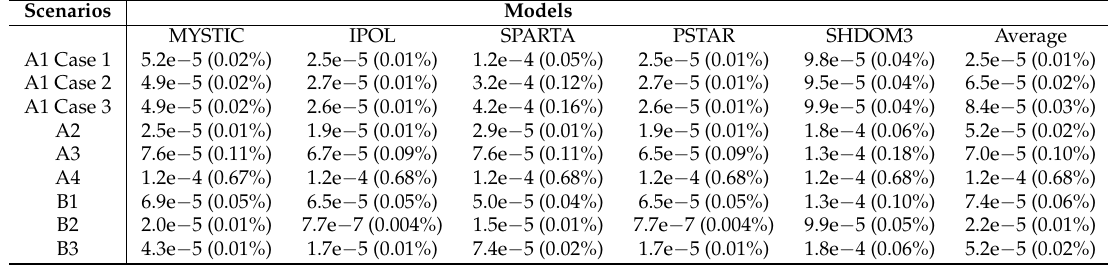
Table A3. Root mean square error (RMSE) and relative RMSE (shown in parenthesis) between VLIDORT and the intercomparison RTMs for reflected total intensity. The values in the row labeled Average represent the RMSE between VLIDORT and the average of all the models.